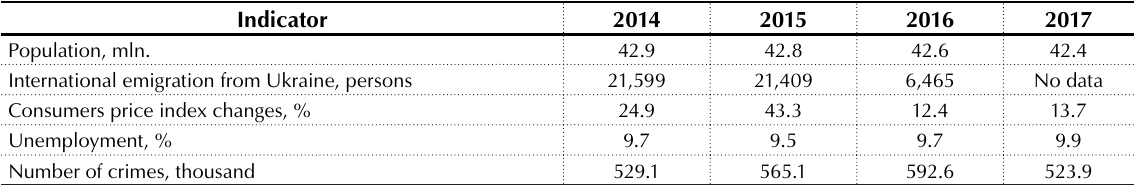
Source: State Statistics Service of Ukraine, 2016, 2017.